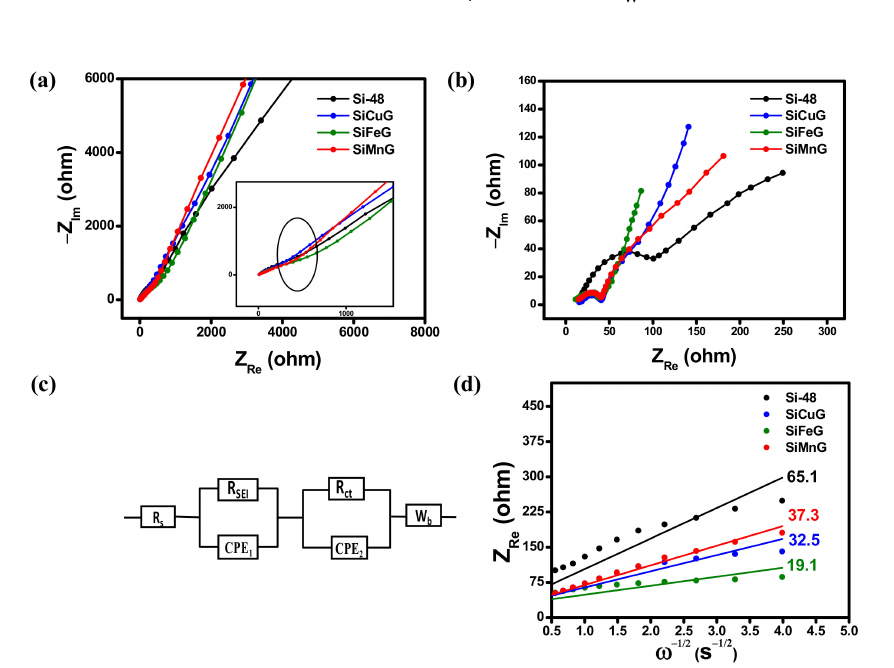
Figure 12. Electrochemical impedance spectroscopy results ( a ) before cycling and ( b ) after 25 cycles at 500 mA g − 1 . ( c ) Equivalent circuit; ( d ) Z Re vs. ω − 1/2 plots of Si-48, SiCuG, SiFeG, and SiMnG vs. Li/Li + as counter electrode with 1 M LiPF 6 in EC:DEC:FEC ( v / v ratio of 5:70:25) electrolyte. Table 2. Summarized impedance values (after cycling) and calculated diffusion coefficients.